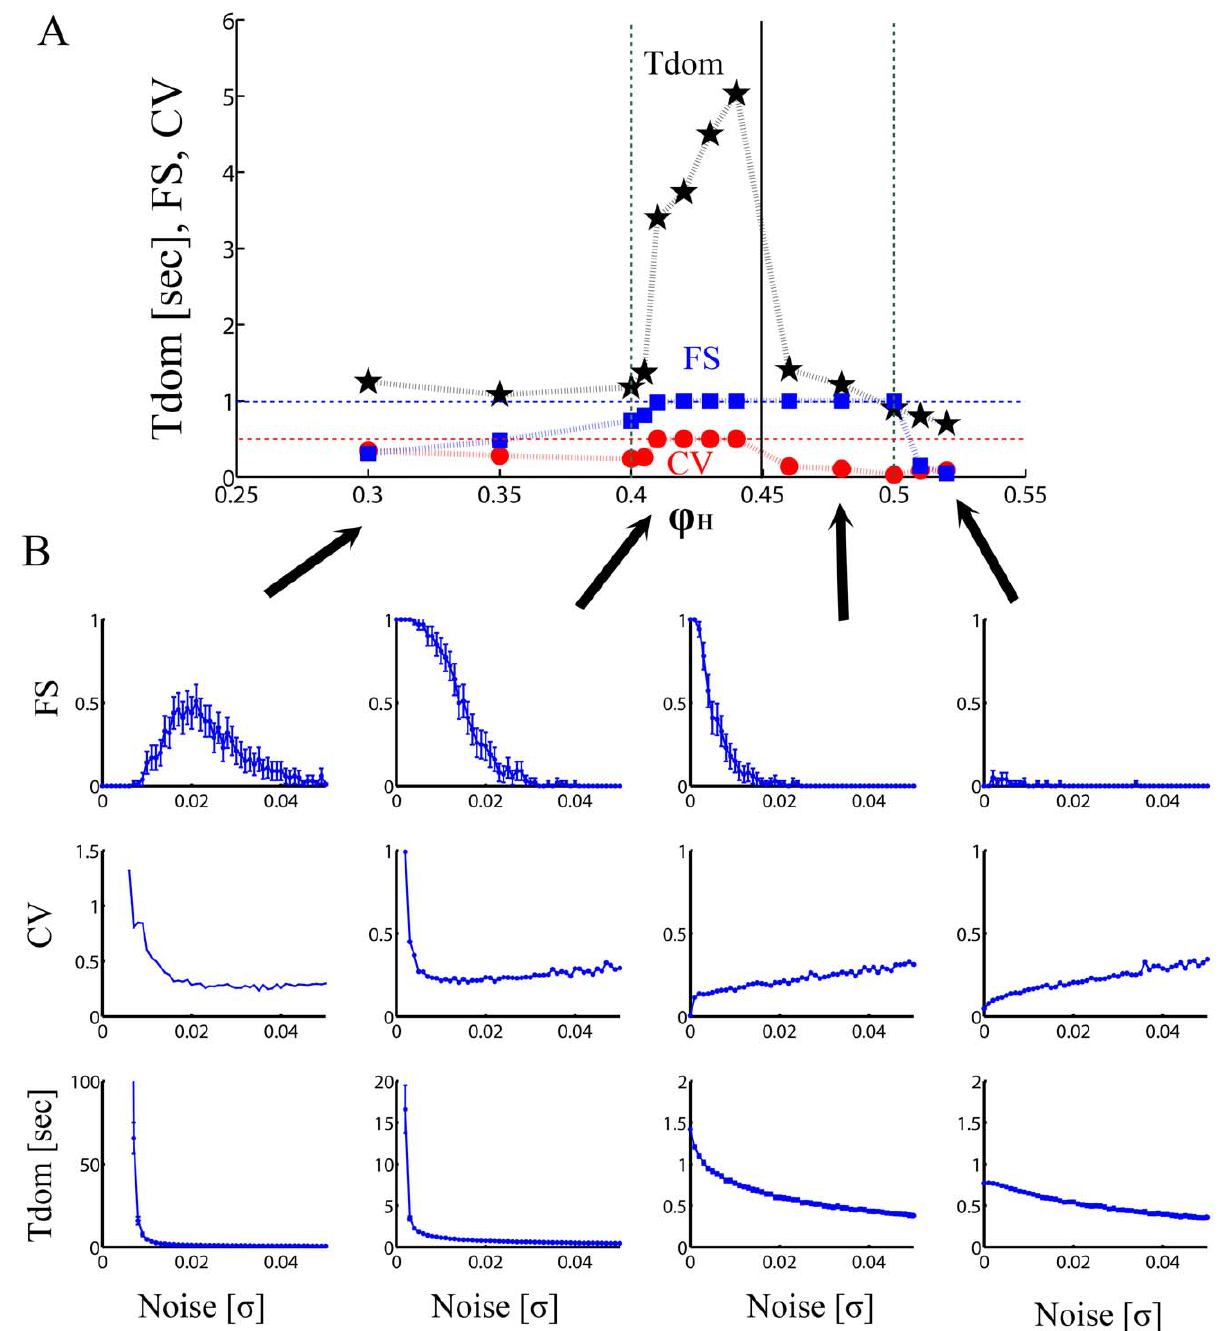
Figure 3. Effect of noise on BFS. (A) Flash suppression ( FS ), Binocular rivalry dominance time ( T dom ), and the coefficient of variation ( CV ) as a function of the adaptation level Q H , and with a level of noise s optimized for each point such that the FS index is maximal and the CV is as near to 0.5 as possible. The black stars indicates the value of T dom , the blue squares FS , and the red dots the corresponding CV . There is only one dynamical region where the model is consistent with the experimental constraints, namely a narrow region just before the bifurcation Q c level of adaptation Q H is such that an optimal level of noise exists for which all neurophysiological (BFS) and psychophysical (BR) constraints can be met. (B) Model simulations, for different fixed levels of adaptation, showing the dependence of these measurements (FS, T dom , CV) on the noise. In this figure four different values of Q H , corresponding to different regions in the bifurcation diagram, are shown.